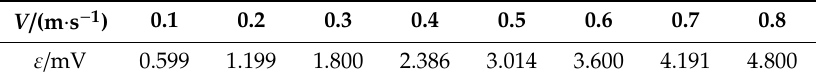
Table 1. Variation of induced electromotive force with fluid